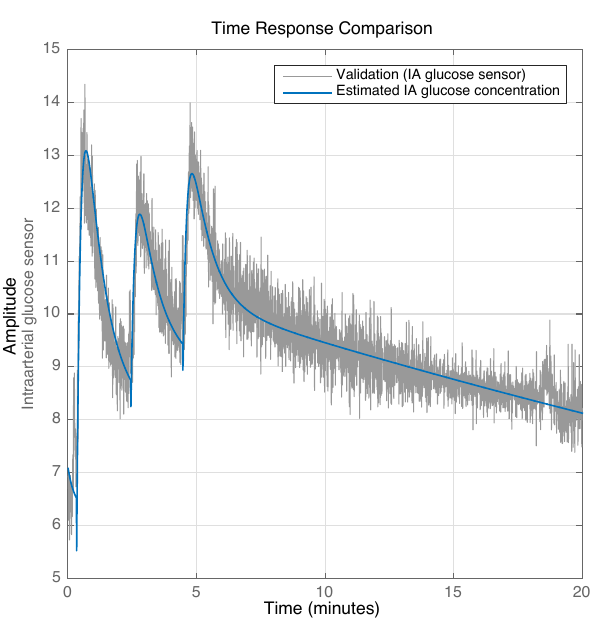
Figure 6: Example of identification of the dynamics H C ( s )h S , IA ( · ) from the glucose bolus to the arterial glucose concentration for segment 2A. The grey signal represents the IA sensor signal, while the blue signal shows a glucose bolus transferred through H C ( s )h S , IA ( · ). Be- ware that the vertical axis has no unit, since the signals are uncalibrated. Copyright: CC BY-NC-SA 4.0.